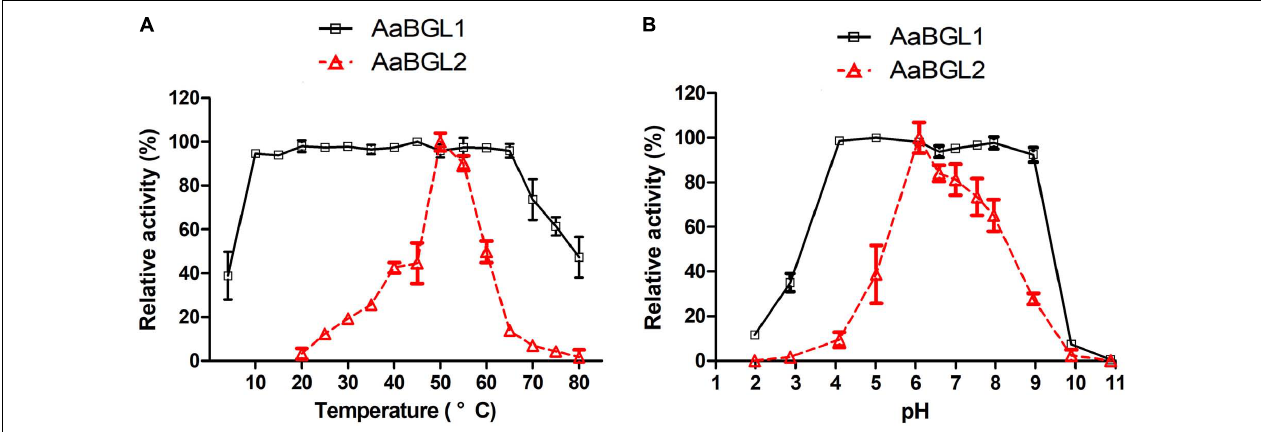
FIGURE 5 | Effects of temperature and pH on the activity and stability of the recombinant AaBGL1 and AaBGL2. (A,B) Effect of (A) temperature and (B) pH on the activity of the recombinant β -glucosidases. The primary activity was designated 100%. Each value in the figure represents the mean ± standard deviation ( n = 3).